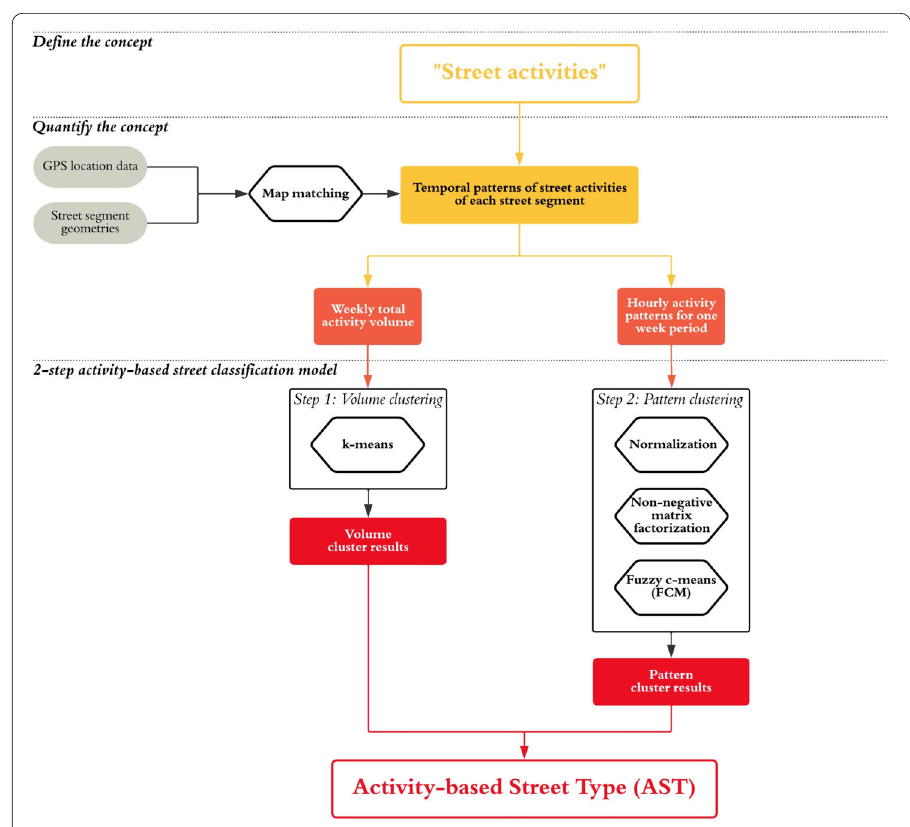
Figure 1 The framework of activity-based street